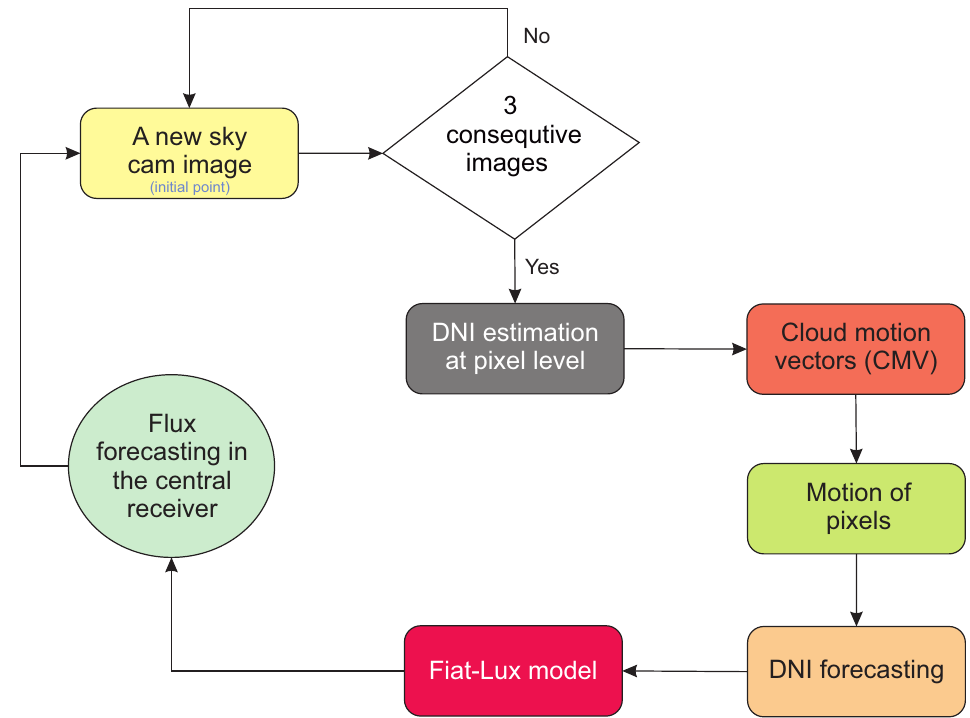
Figure 2. Flowchart of the process used for the DNI forecasting at the PSA